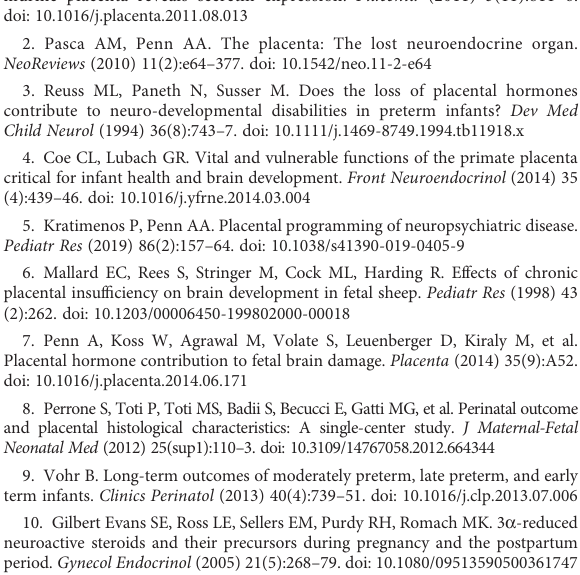
SUPPLEMENTARY FIGURE 6 Preterm birth is associated with dysregulation of layer-speci fi c marker expression in the Brodmann Area 10. (A) Schematic of the age terminology during the perinatal period used for the human study. (B) Cux1-mRNA/FoxP2-mRNAratiodeterminedbyqRT-PCR.n=9maleterm,4 female term, 4 male preterm, 5 female preterm. Data is presented as mean fold-changes ± SEM. Two-way sex by term ANOVA with Sidak ’ s post-hoc comparison test. (A) was created with BioRender.com. SUPPLEMENTARY TABLE 1 Sequences of the PCR primers. SUPPLEMENTARY TABLE 2 List of the signi fi cantly dysregulated genes in the cerebral cortex of P30 plKO males (sheet 1) and females (sheet 2), as compared with their littermate controls. SUPPLEMENTARY TABLE 3 (A,B) Top15signi fi cantenrichedpathwaysinplKOcerebralcortexwithp- Values and associated genes. Enriched gene functional groups identi fi ed with Ingenuity Pathway Analysis software (Qiagen) in males (A) and in females (B)